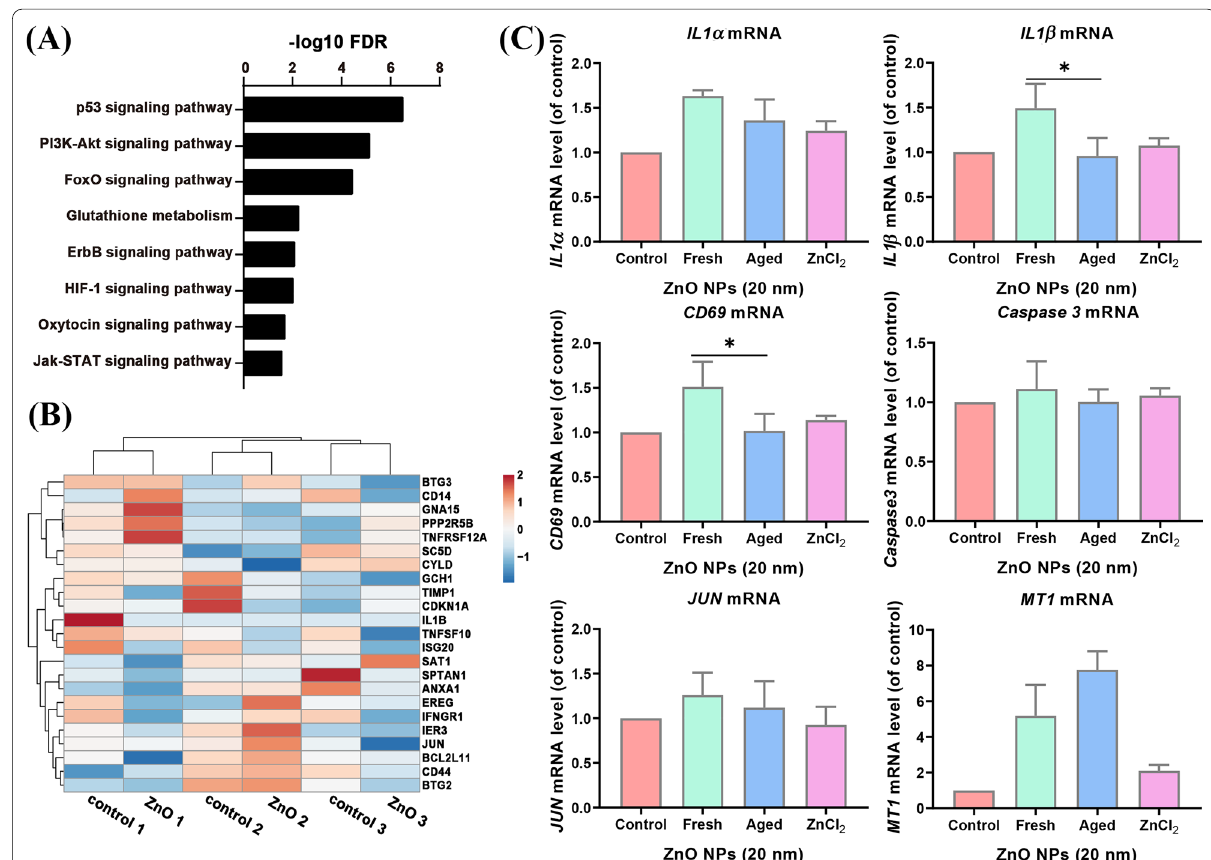
Fig. 5 Apoptosis pathway was not enriched in RNA-seq data of aged ZnO NP-treated A L cells. ( A ) The gene ontology analysis of enriched pathways from aged ZnO NP-treated A